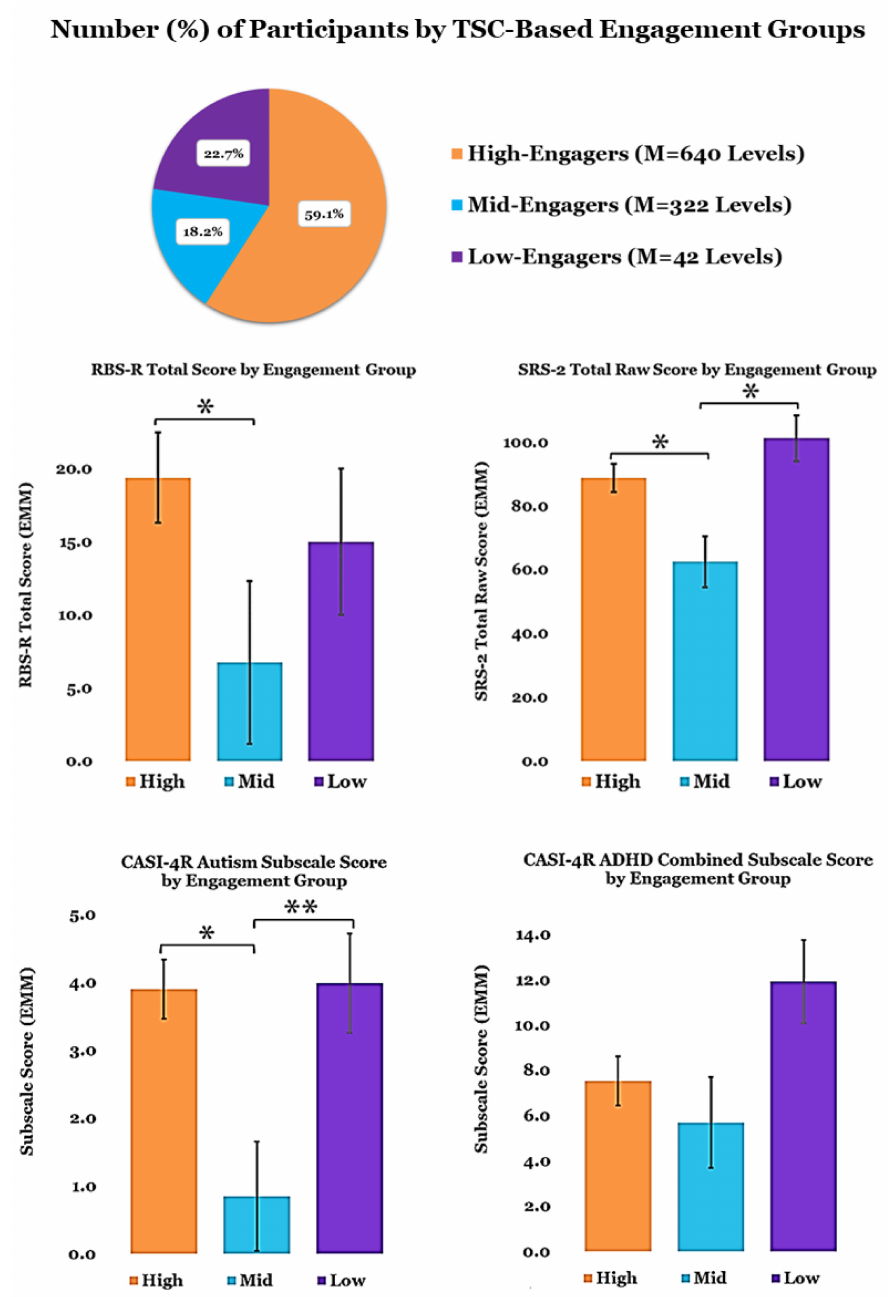
Figure 3. Two-Step Cluster Analysis-Based Engagement Groups (Mean Targeted Cognitive Training Levels Completed: High = 640; Mid = 322; Low = 42.8).; Baseline clinical assessment scores by Engagement Sub-Grouping. Covariates appearing in the model are evaluated at the following values: Age = 17.0, Sex = 0.18. Error Bars = ± 1 SE; ** p < 0.01, * p <